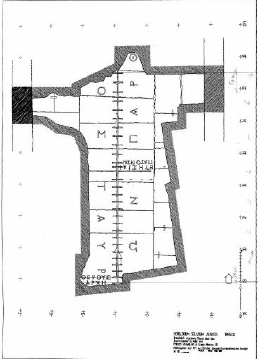
Figure 14: Drawing by Leonhardt (1994) A sundial and a meridian line both measure the position of the sun's shadow and the length of day and night, but the meridian line only marks the noon (meridianus). When the sun reaches its peak, the shadow falls to the north and gets shorter as the year progresses. At the summer solstice, the longest day of the year, the shadow has moved back the whole meridian line. As the sun declination becomes smaller, the midday shadow lengthens and becomes longer and longer until the winter solstice, the shortest day of the year. With the application of the gnomon and its "shadow tablets", practical astronomy, even in ancient science, becomes a branch of geometry with which later developing trigonometry is connected. 17